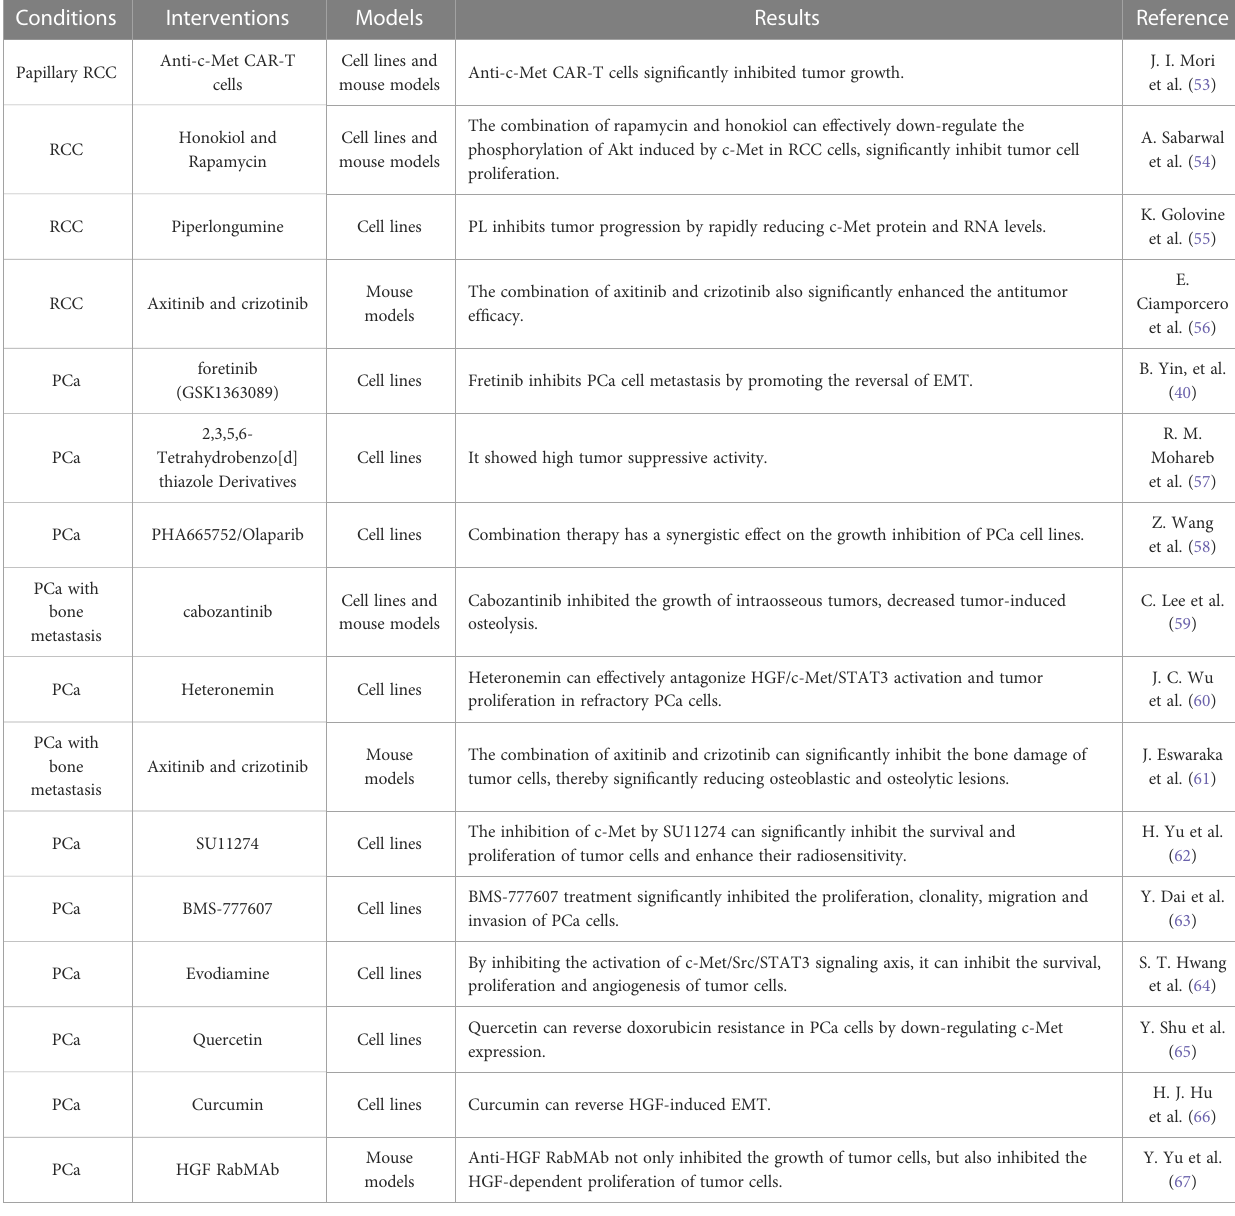
TABLE 2 Preclinical studies of c-Met targeting therapy in urologic